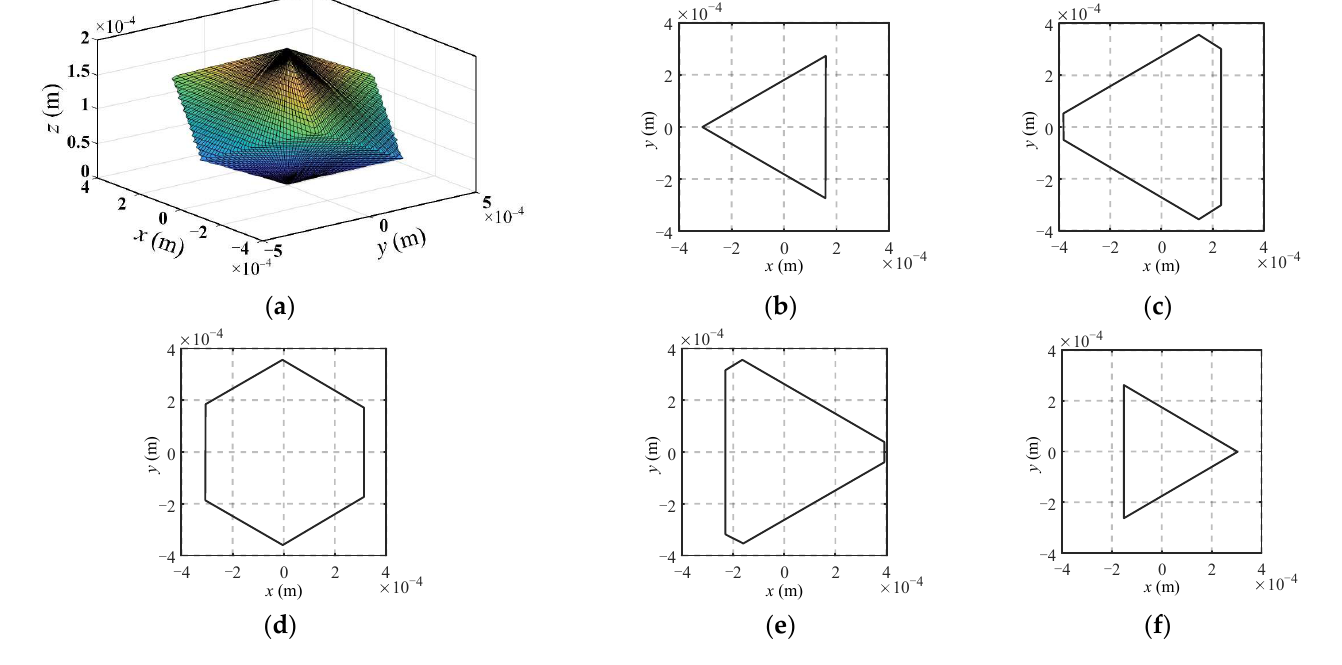
Figure 2. The workspace of the 3-PSS flexible parallel micromanipulator and sectional shapes of workspace at different heights. ( a ) The workspace; ( b ) z = 50 μm; ( c ) z = 75 μm; ( d ) z = 100 μm; ( e ) z = 125 μm; ( f ) z = 150 μm.